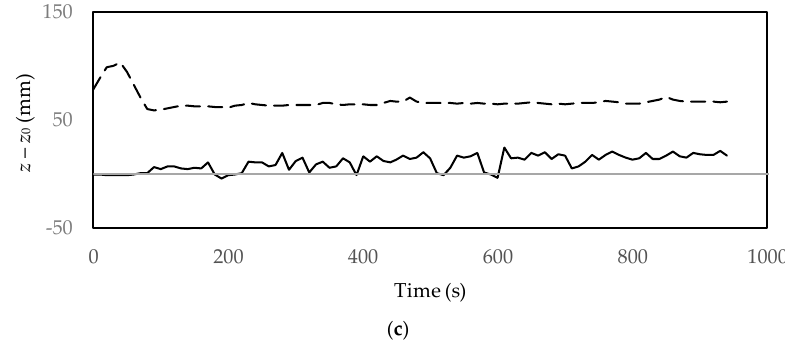
Figure 16. Temporal evolution of the water surface (dashed) and bed elevation (continuous) at ( a ) 1.5 m; ( b ) 1.75 m and ( c ) 2 m from the flume inlet for the sample experiment. The original bed elevation z 0 is indicated by the gray line.